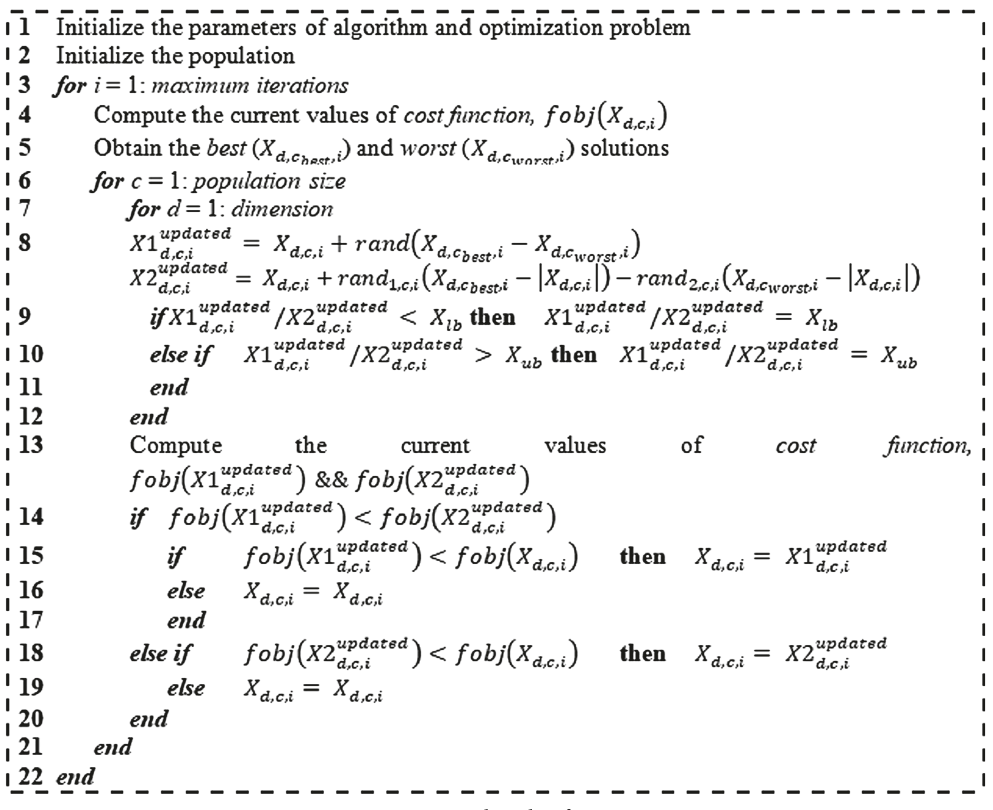
Figure 4: Pseudocode of